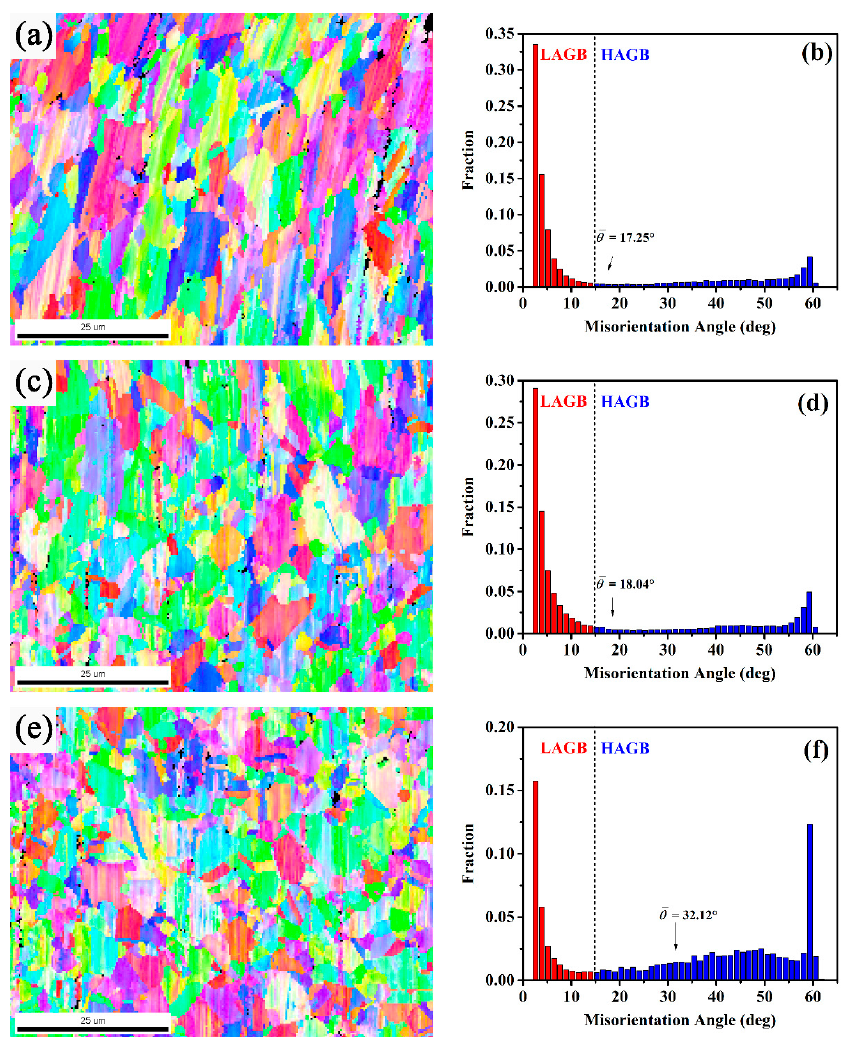
Figure 9. OIM maps and grain misorientation angle distributions of the deformed specimens at 1080 °C with strain rate of 1 × 10 − 3 s − 1 at different ductility, respectively: ( a , b ) 61.8%, ( c , d ) 350.5% and ( e , f ) 760.4%.